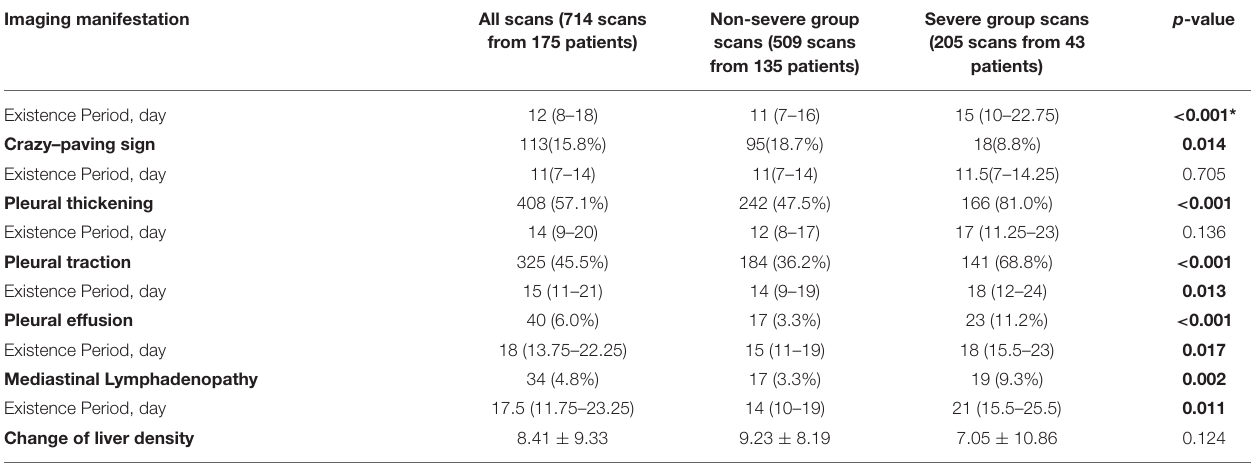
total of 299 follow-up scans from 135 patients were